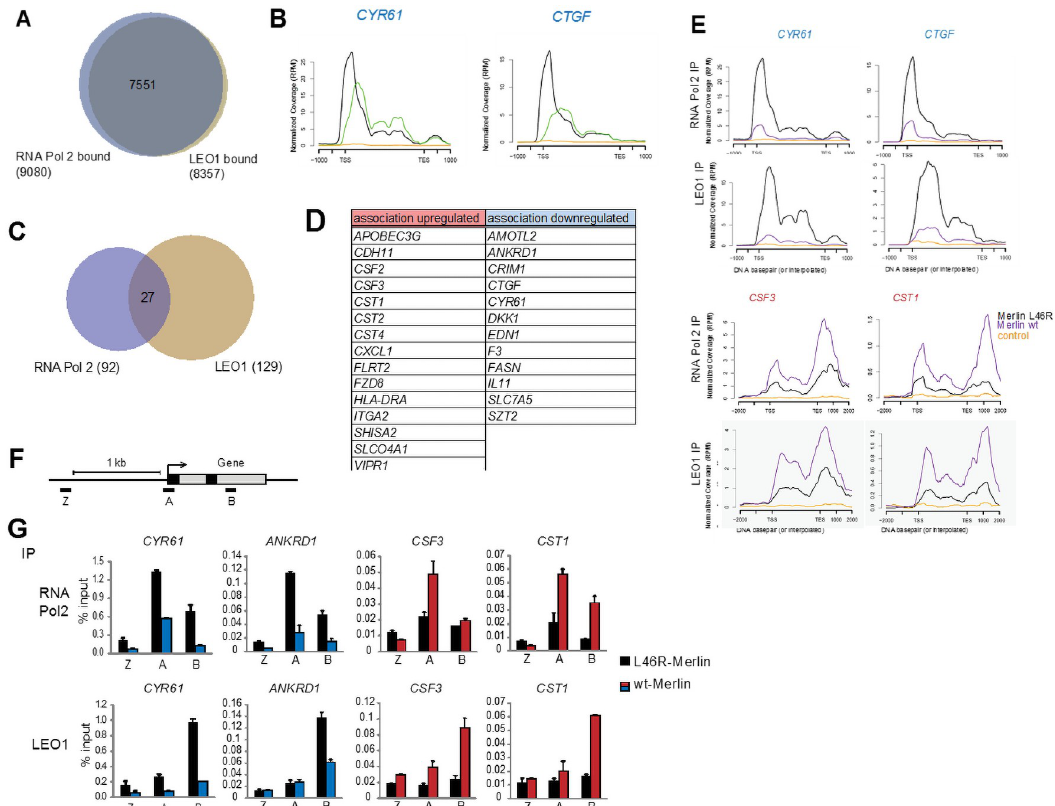
Fig 6. Merlin regulates PAFC association with chromatin of a subset of genes. (A) Most RNA Pol II bound genes are also bound by LEO1. Overlap of RNA Pol II- and LEO1-bound genes in Merlin L46R cells as determined by ChIP-seq in MDA-MB-231 cells. (B) Plots of the short read coverage across the genomic regions of CYR61 and CTGF example genes showing LEO1 (green) association peaks downstream of RNA Pol II (black). Antibody control is in orange. (C) Overlap of RNA Pol II and LEO1 bound genes significantly regulated by wild type Merlin expression ( > 1.5-fold change, > 2-fold over ctrl antibody IP). (D) Genes from C where both RNA Pol II and LEO1 association is regulated by Merlin expression. (E) Plots of the short read coverage for selected genes showing regulation of RNA Pol II and LEO1 association by wt (purple) compared to mutant (black) Merlin expression. Blue and red denote down- and up-regulation by Merlin expression. (F) Schematic showing location of primers used in G. (G) Validation of ChIP-seq results. Chromatin from MDA-MB-231 cells expressing wild type or L46R Merlin was IPed using a RNA Pol II, LEO1 and control antibody and qPCRs performed with the indicated primers. Error bars represent SD from two independent PCRs. Representative of three independent experiments. TSS: transcriptional start site, TES: transcriptional end